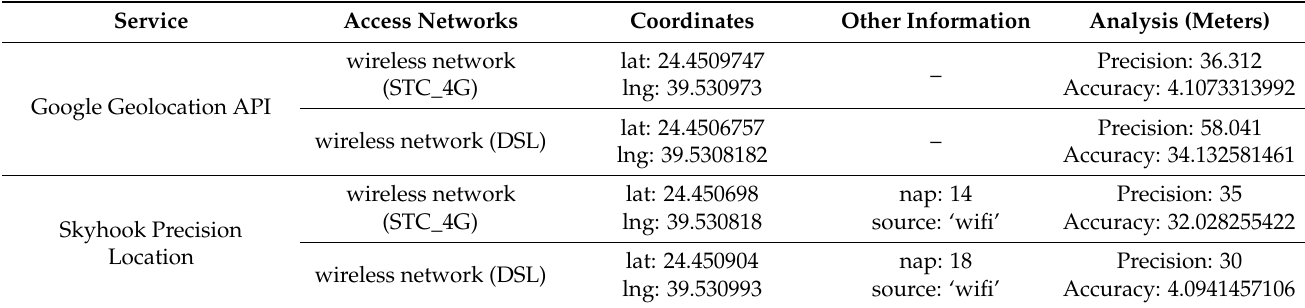
Table 13. Result and Comparison of WPS in Windows.